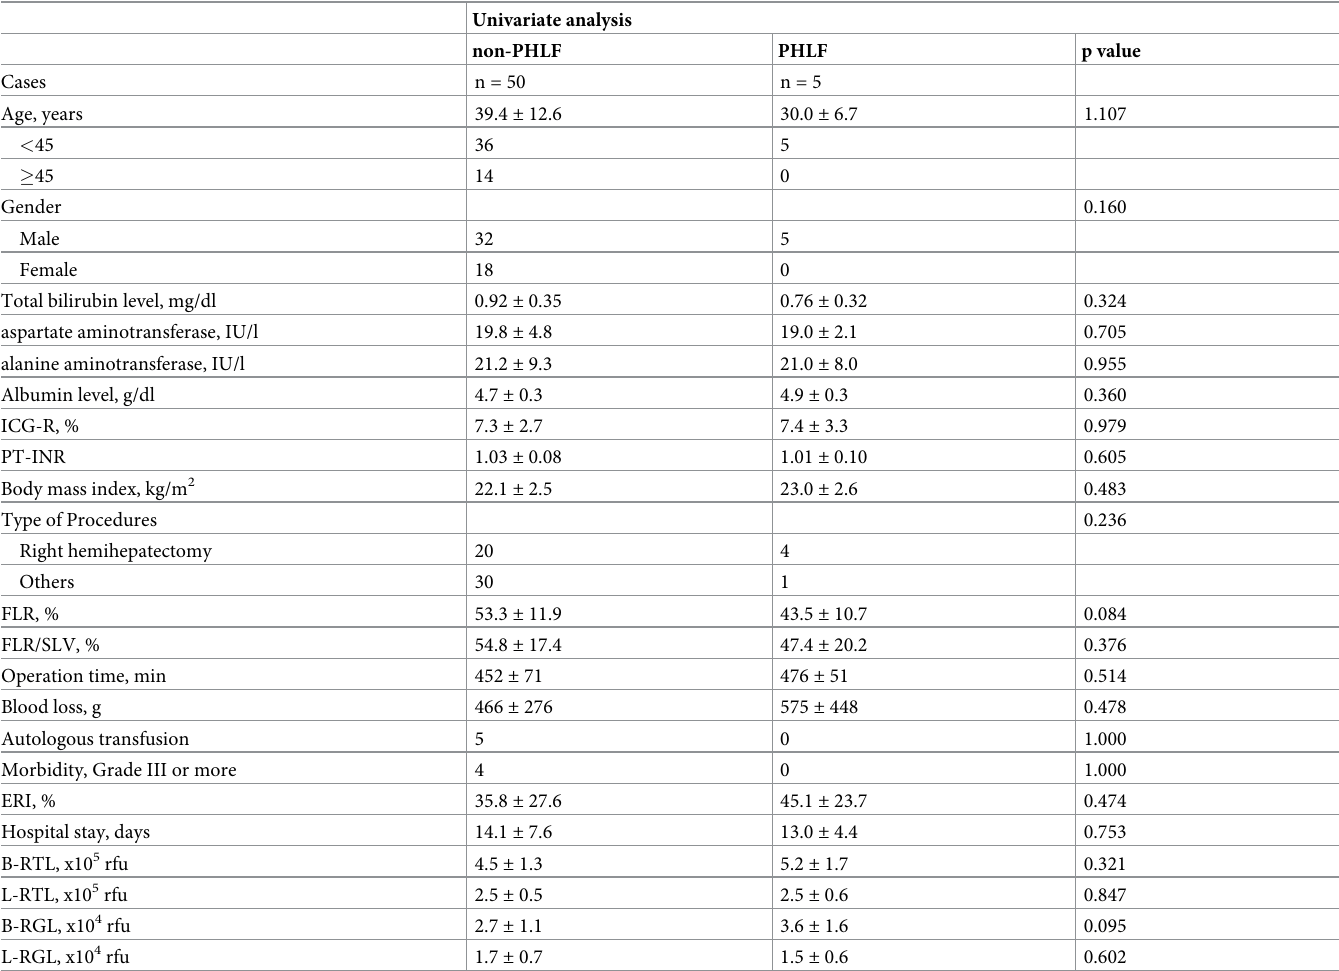
Table 2. Clinical characteristics of liver donors according to